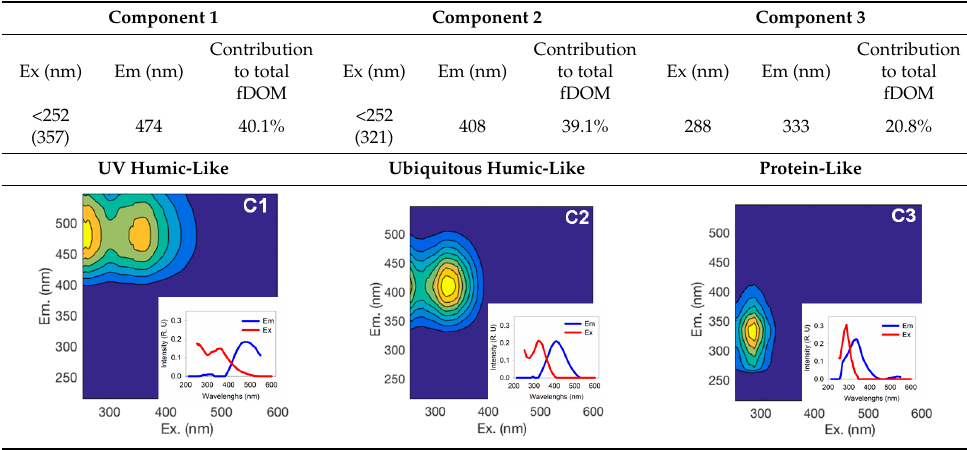
Table 2. Positions of excitation (Ex) emission (Em) maxima of the three components of fluorescent dissolved organic matter (fDOM) identified by the PARAFAC model using all collected samples independently collected in the Dam and Forest catchments. Two lines in the excitation (red lines) and emission (blue lines) spectra show half-split validation results.